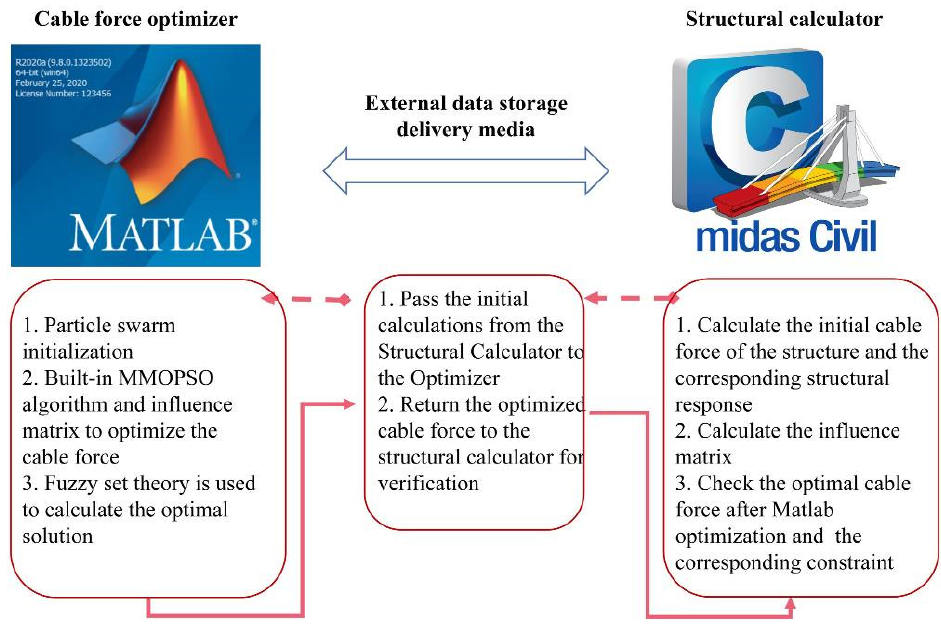
Figure 1. Collaboration between Midas/Civil and MATLAB.